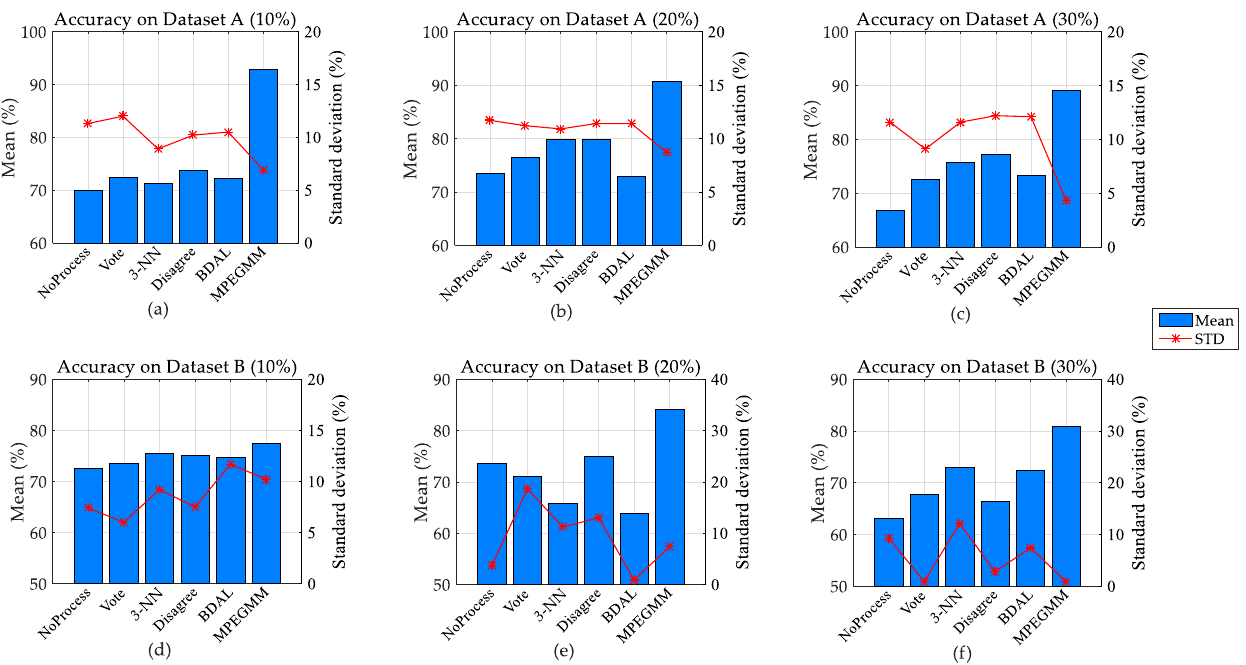
Figure 6. Accuracy under setting 1. ( a ) Accuracy on dataset A with LNR = 10%; ( b ) accuracy on dataset A with label-noise ratio ( LNR ) = 20%; ( c ) accuracy on dataset A with LNR = 30%; ( d ) accuracy on dataset B with LNR = 10%; ( e ) accuracy on dataset B with LNR = 20%; ( f ) accuracy on dataset B with LNR = 30%.